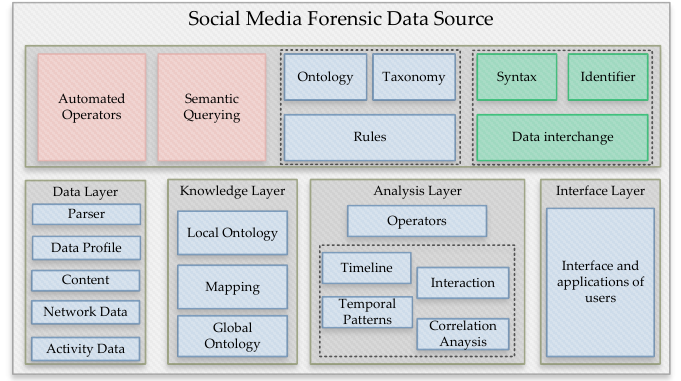
Figure 2. Multi-layered implementation